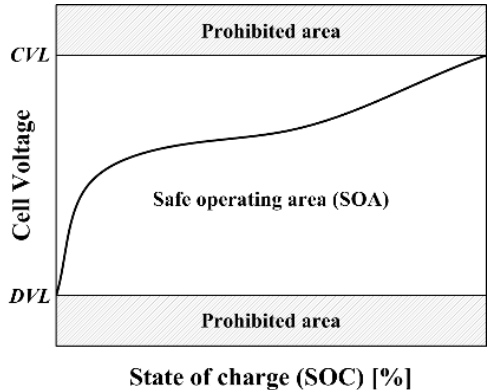
Figure 1. Cell voltage versus state of charge characteristic of the Li-ion battery. Legend: CVL, charging voltage limit; DVL, discharging voltage limit.